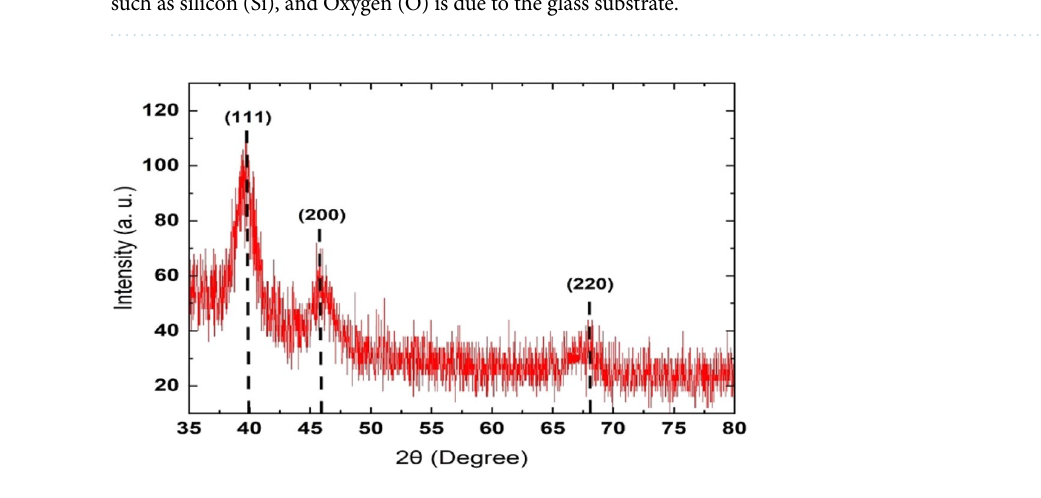
Figure 6. XRD pattern of the produced Pt/Pd composite